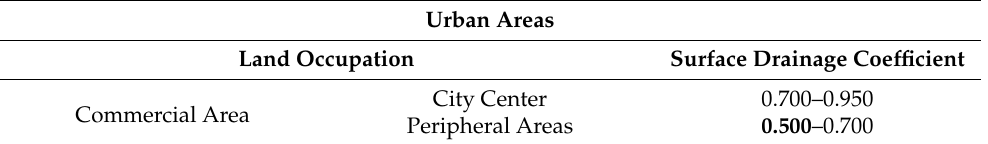
Table 4. Surface drainage coefficient adopted (Source: [25]).